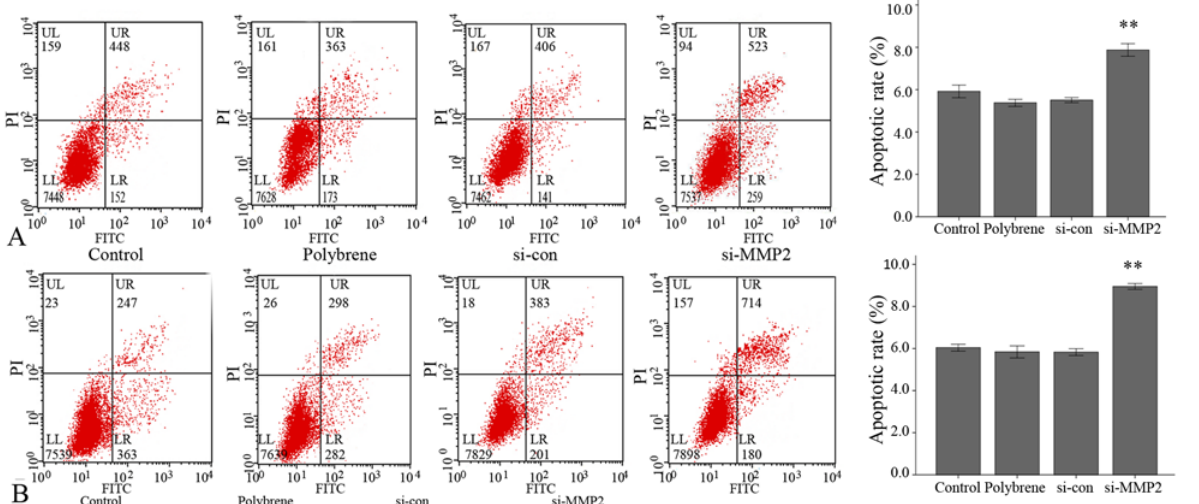
Figure 3 . The apoptotic rates of HepG2 (A; at 48 h after transduction) and Huh7 cells (B; at 72 h after transduction) using flow cytometry. The numbers in the graphs are the counts of the cells detected with flow cytometry (UL, necrotic cells; LL, non-apoptotic cells; LR, cells at the early apoptotic stage; and UR, cells at the late apoptotic stage). The apoptotic rate = the apoptotic rate at the early stage (LR) + that at the late stage (UR). **P<0.01 vs. the normal control group, according to one-factor analysis of variance (ANOVA) followed by a post hoc least significant difference (LSD) test.